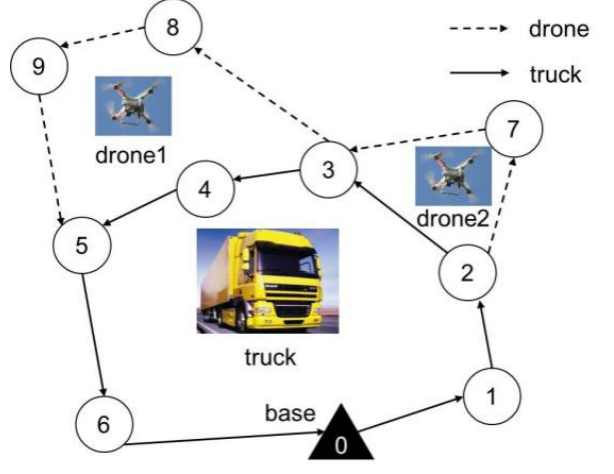
Figure 1. A truck and multiple drones for target